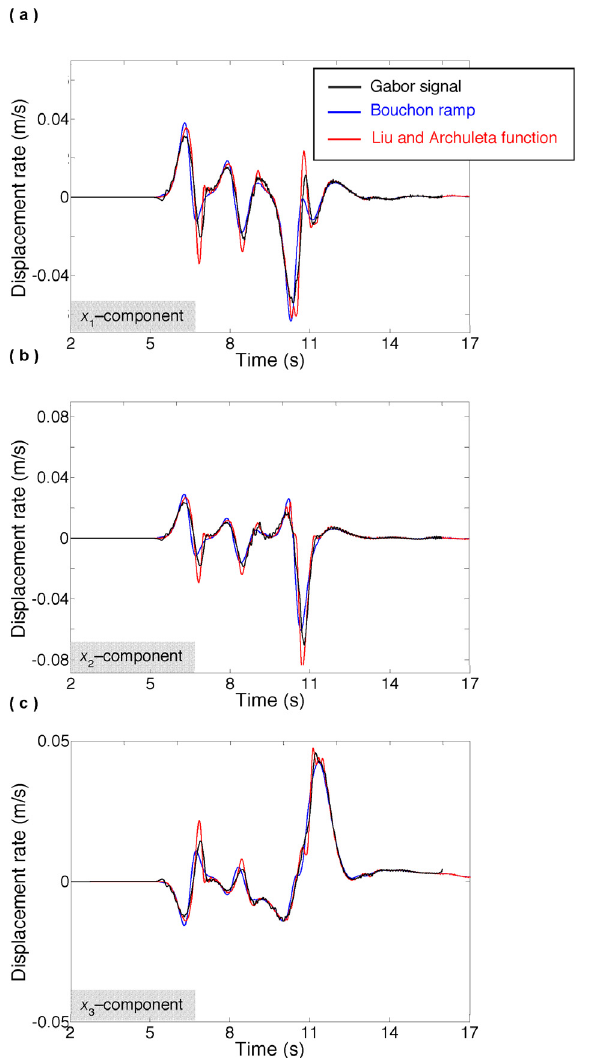
> (so that namely it is Figure 1. (a) Comparison between the five point-source time functions assumed in the present study, normalized by < u tot reported the behavior of s ( t ), as defined in Equation (2)). The adopted parameters are: f = 0.225 Hz, t = 1.5 s, c = 1 s (Equation (3)); t = G G G B = 0.8 s (Equation (5)); t = 1.5 s (Equation (6)); t = 1.4 s (Equation (8)). In the case of the Bouchon ramp we apply a time 0.6 s (Equation (4)); t CC Y LA shift of −0.7 s; the dashed curve represents the unshifted function. (b) The same as in panel (a), but now we plot the time derivative of s ( t ).